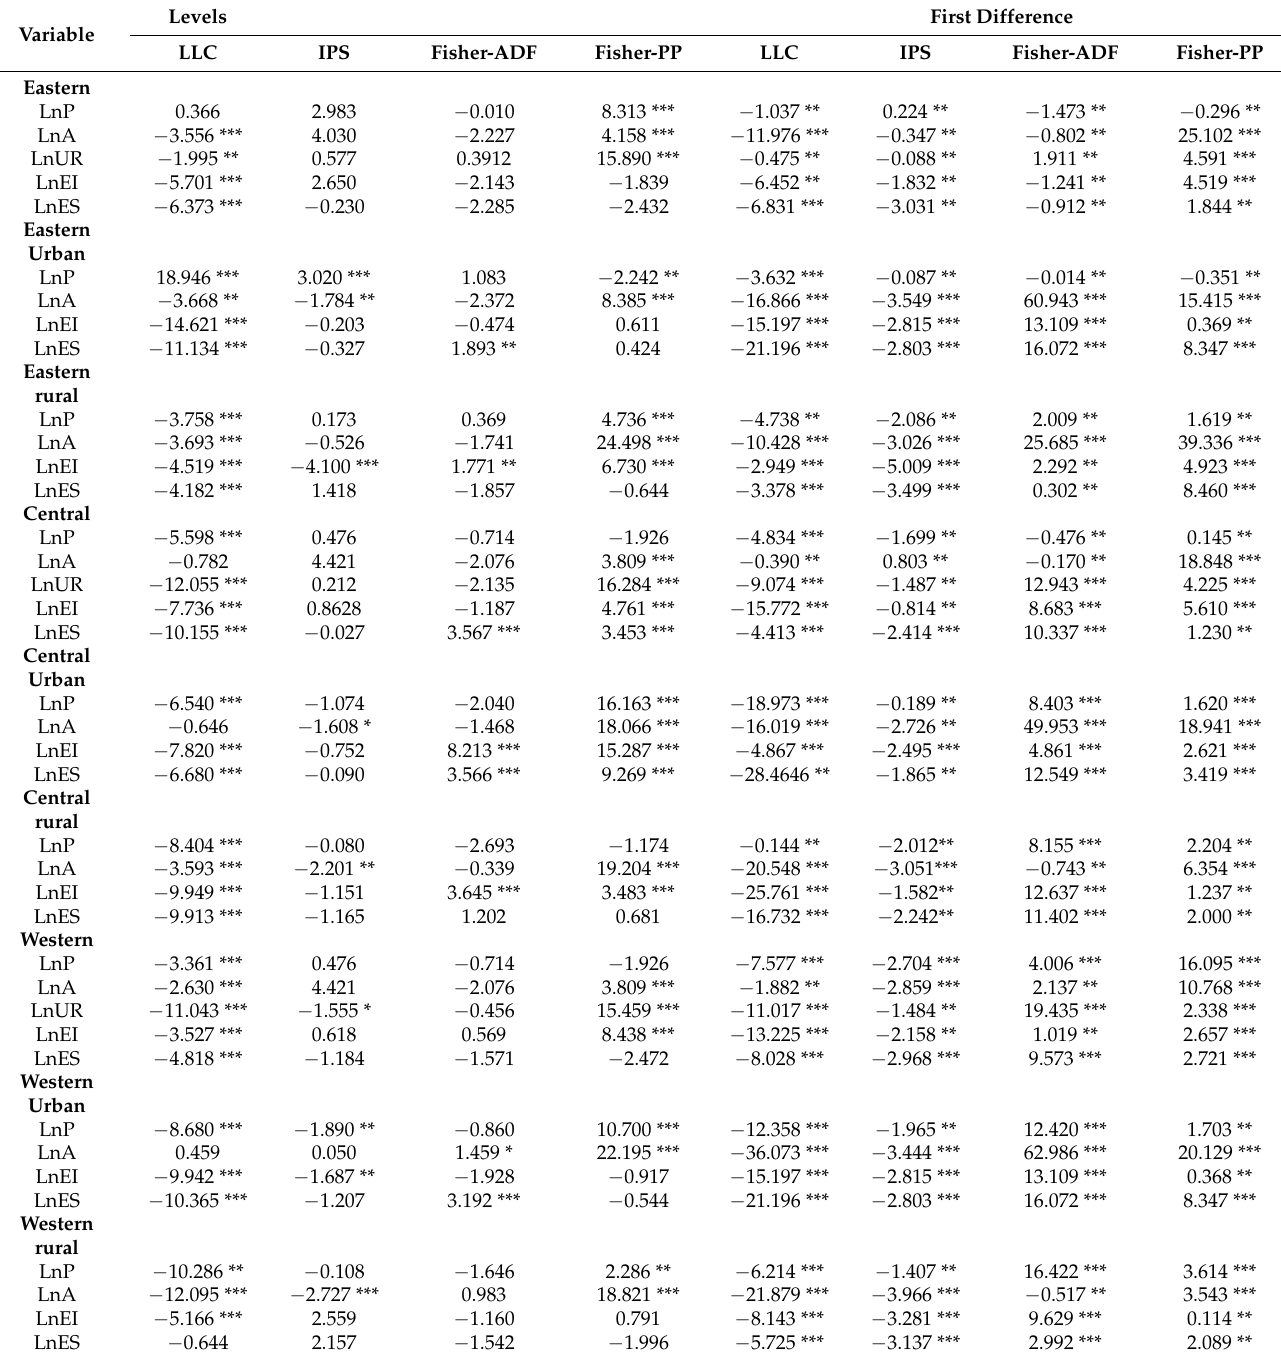
Table 2. The panel unit root tests for different